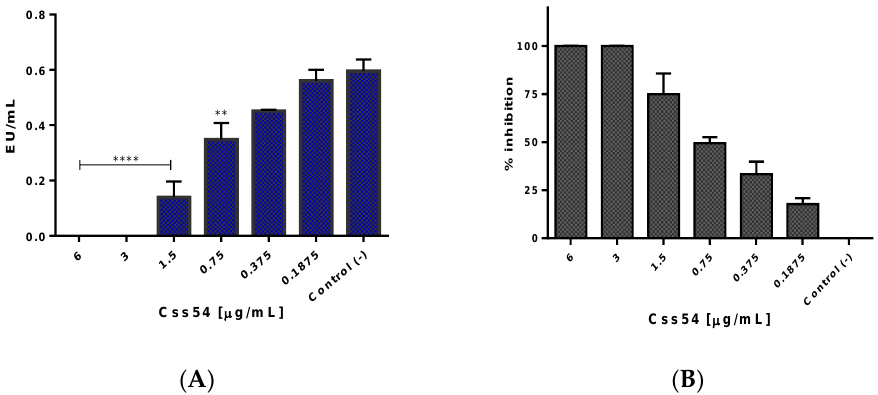
Figure 5. Neutralization of S . Typhimurium LPS by the Css54 peptide. Different concentrations (0.18 –6 μg/mL) of Css54 were incubated with 0.5 EU/mL of S. Typhimurium LPS for 30 min. ( A ) Units of endotoxin (EU) per mL with respect to Css54 concentration; ( B ) Percentage of inhibition achieved by incubating the peptide with LPS. Control ( − ): LPS + water. This figure shows the average of three independent experiments, (** p < 0.005, **** p < 0.0001).